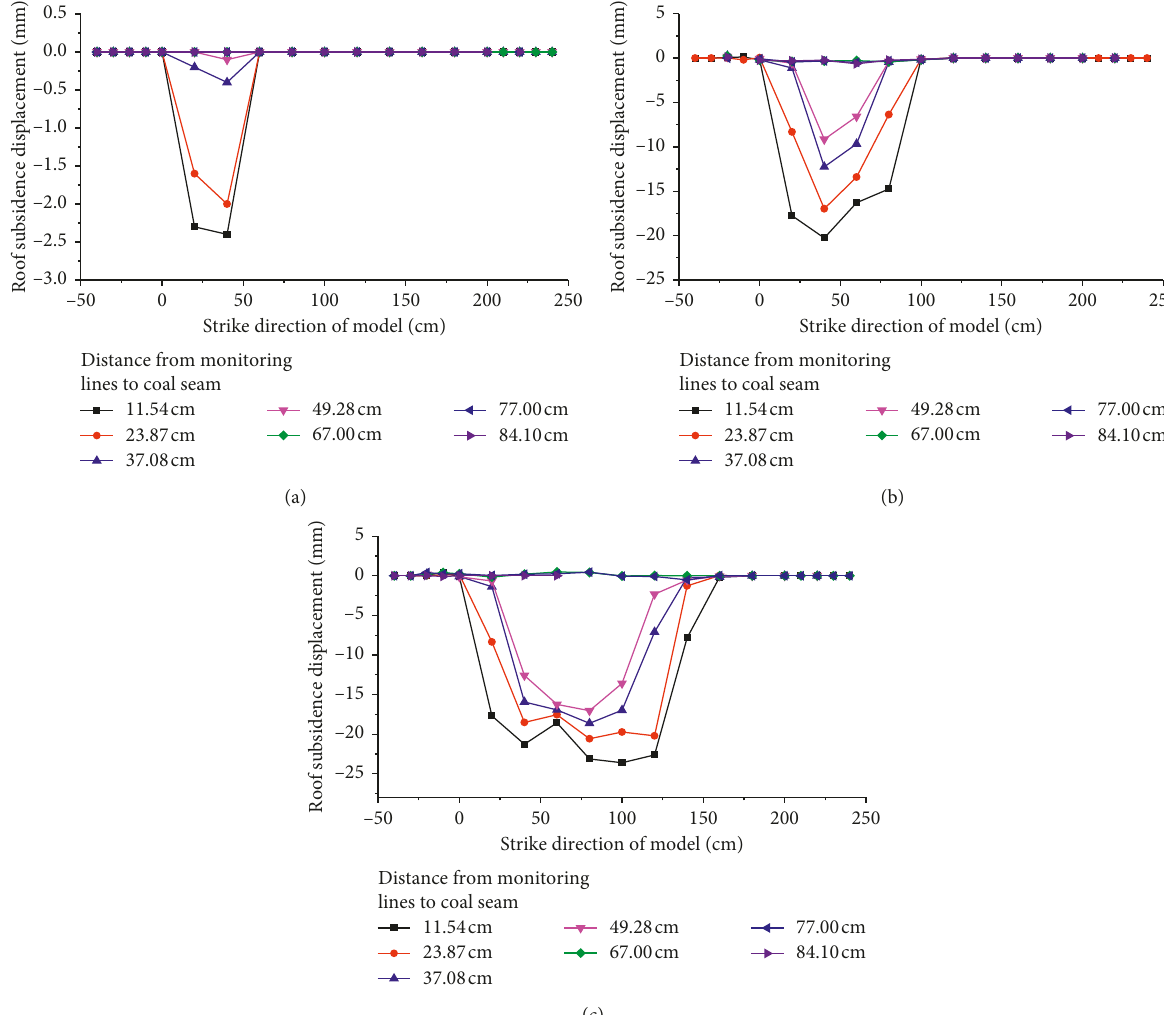
Figure 6: The subsidence displacement curves of different workface advance distances: (a) 50cm; (b) 100cm; (c) 150cm.